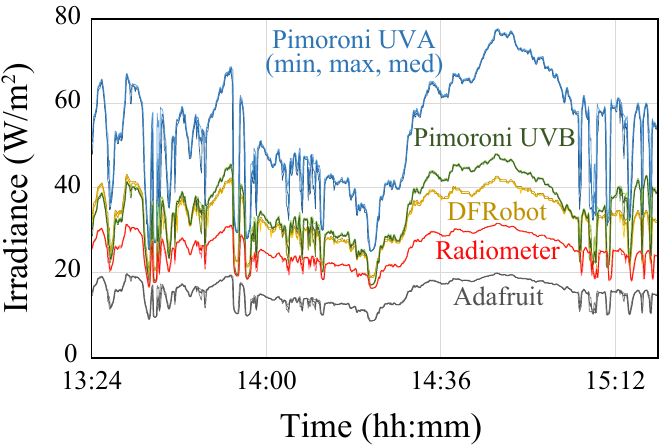
Figure 4. Graphical representation of the data captured by the three sensors and the radiometer on the first day.